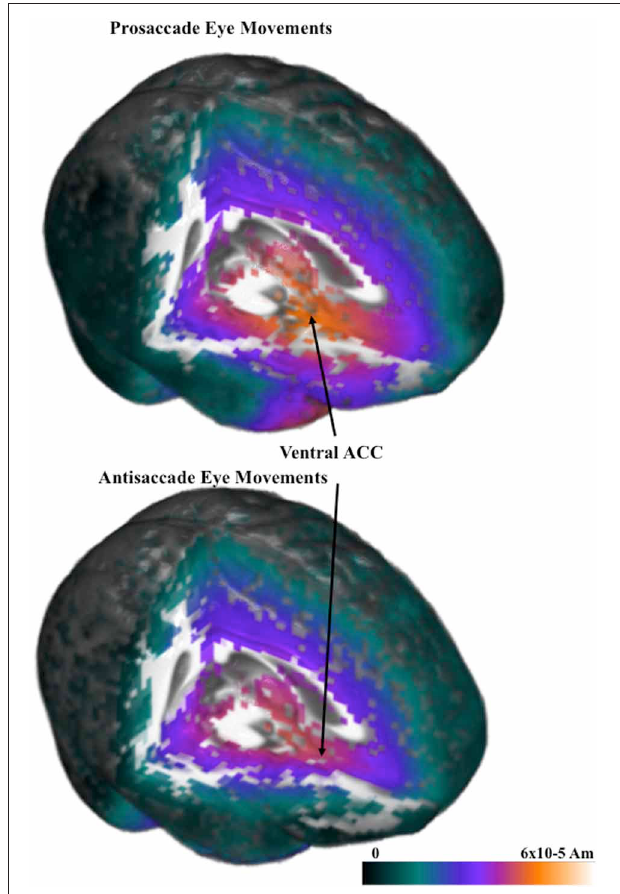
FIGURE 5 | Current density reconstruction for the pressaccadic spike potential for prosaccade and antisaccade eye movements.